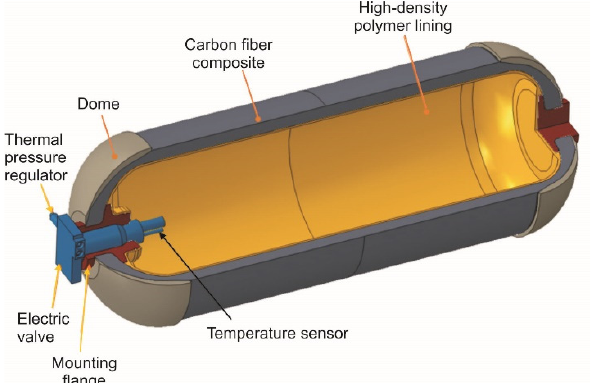
Figure 8. Example of a vehicle hydrogen tank made of Type IV carbon fiber composite (COPV) [19]; tank capacity—5 kg of hydrogen at a pressure of 70 MPa.